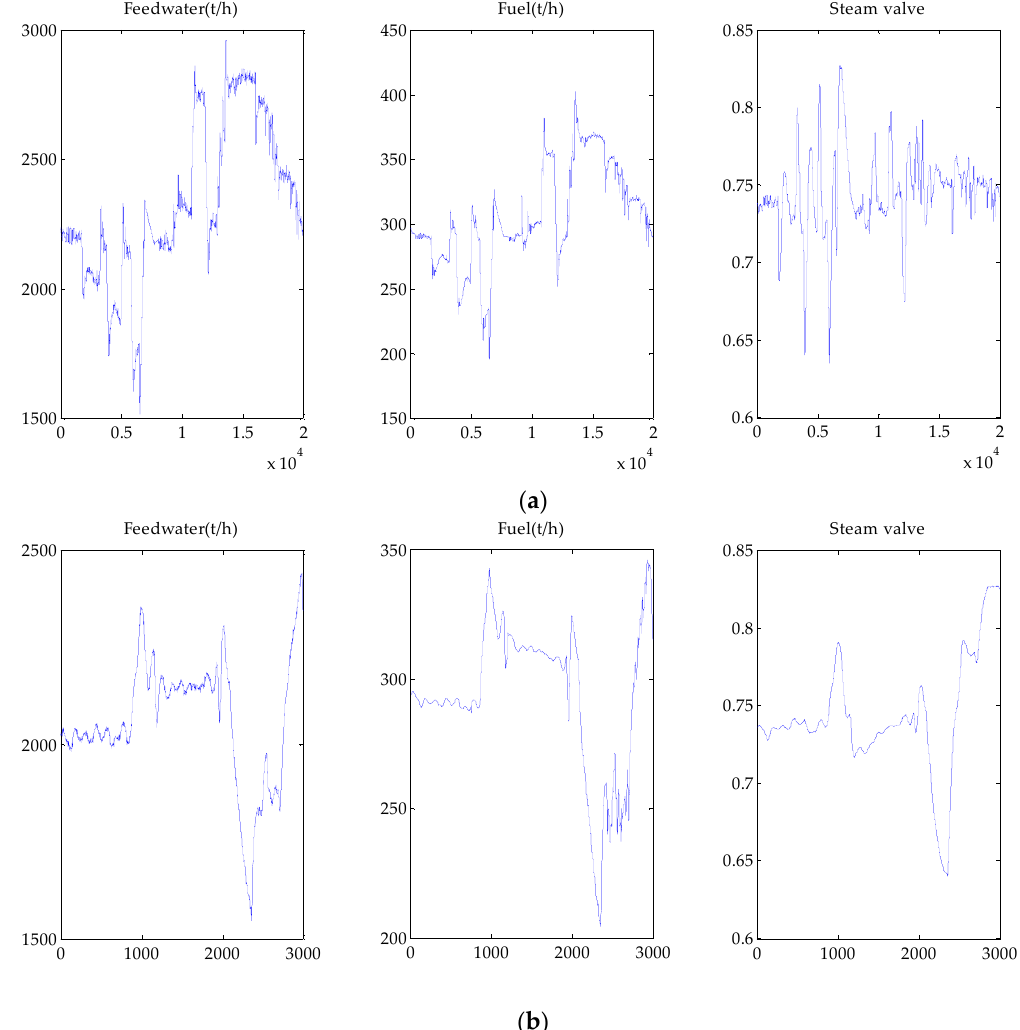
Figure 7. The datasets used for training ( a ) and validating ( b ).